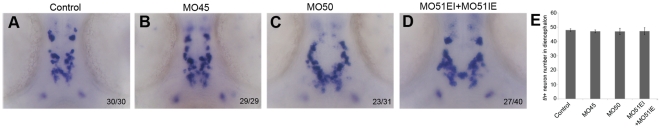
RNA whole mount in situ hybridization of 3 dpf embryos with th probe didn't show significant loss of DA neurons in LRRK2 morphants.A to D, the diencephalon region of zebrafish embryos, dorsal view, anterior to the top. The numbers on bottom right corner showed number of the embryos with a certain phenotype/number of total embryos in that group. There was not obvious alteration of DA neurons pattern in the diencephalon of the morphants (B, C, and D). E, quantative result of th positive neurons in the diencephalon. There was not significant DA neurons loss in all three morphant groups. n = 20 in each group, P>>0.05 in all comparisons.